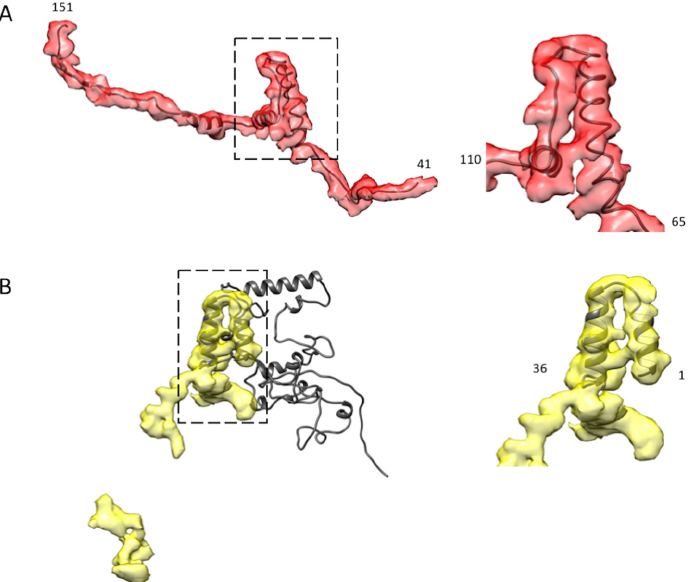
Figure 6. AlphaFold2 modeling of Bombus myofilin and flightin. ( A ) The AlphaFold2 atomic model of the flightin WYR motif fits well into the globular domain in a zoomed-in view (right) that roughly extends from residue 65 to residue 110, which is also the region of conserved sequence and similar reconstruction density in Drosophila and Lethocerus . The full atomic model starts from residue 41 to the residue 151 at the C-terminus (left). ( B ) The AlphaFold2 atomic model of myofilin only fits well at the N-terminal LKG domain up to residue 36 (right), which corresponds to the region of high sequence and density conservation in Drosophila and Lethocerus , while the rest of the AlphaFold2 model has poor reliability (left).